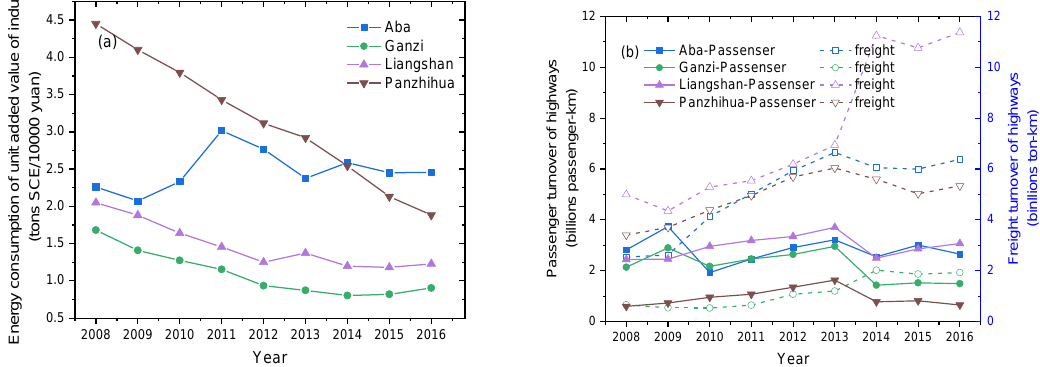
Figure 6. ( a ) Energy consumption per unit industrial added value and ( b ) highway passenger and freight turnover in Aba, Ganzi, Liangshan, and Panzhihua in 2008 – 2016.